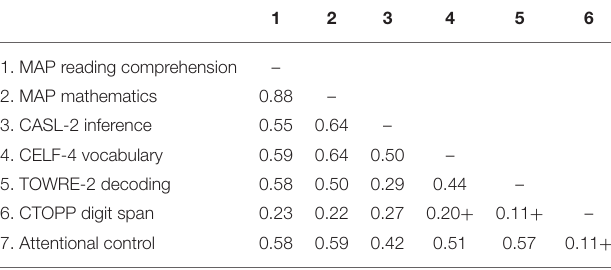
TABLE 2 | Correlations between